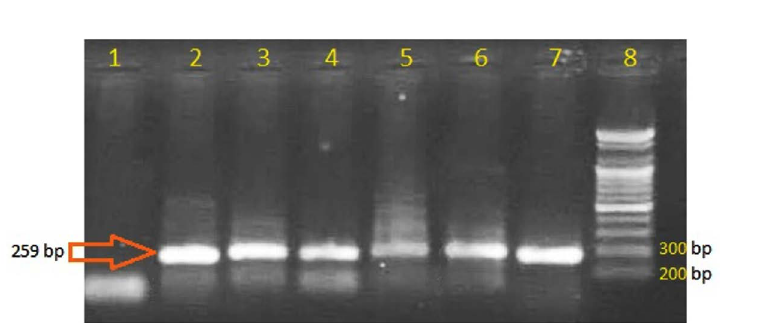
Fig. 2. PCR amplification of OXA-48- β -lactamase. Lanes 2-7 are positive amplification bands with the expected size indicating the presence of the OXA-48 gene. Lane 1 is negative control. Lane 8 is DNA